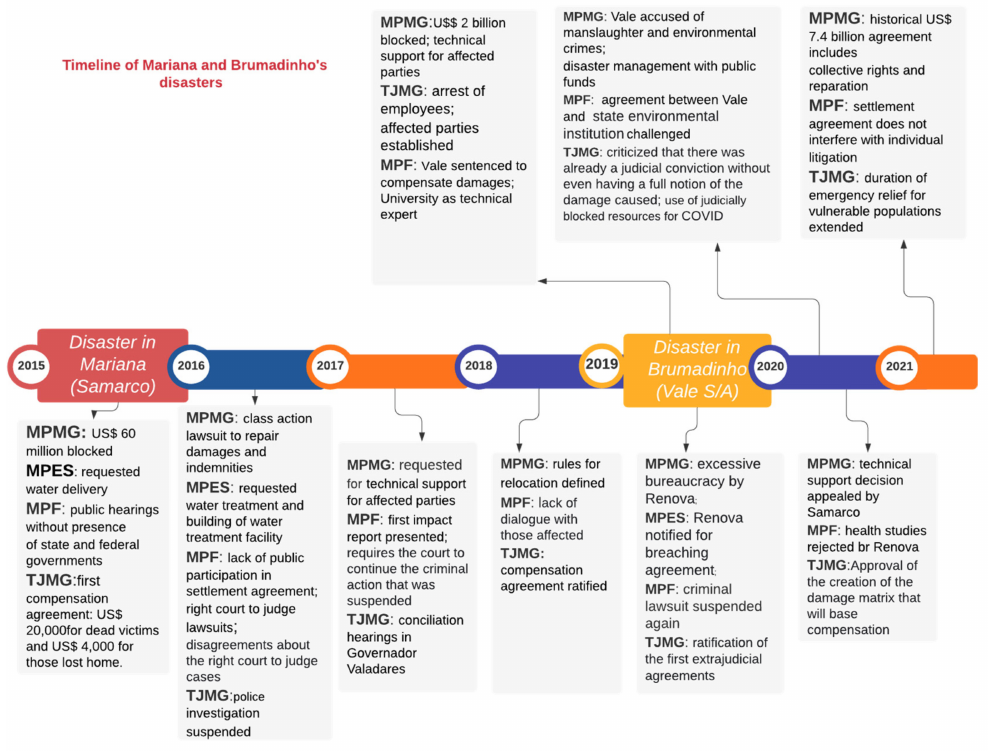
Figure 7. Timeline of disasters (sources: